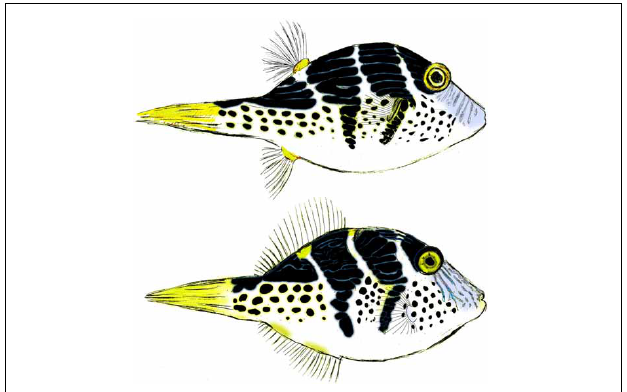
FIGURE 1 | Batesian mimicry: The highly poisonous pufferfish, Canthigaster valentine (top) and its edible mimic Paraluteres prionurus (bottom). The remarkable degree of precision in the deception reveals the sophisticated recognition capabilities of the neural networks of local predatory reef fish (Caley and Schluter, 2003). These networks despite being orders of magnitude smaller than those of primates seem capable of matching human vision in performance and motivate the investigation of very simple solutions to the problem of visual recognition. (Note: the dorsal, anal and pectoral fins are virtually invisible in the animals’ natural environment).